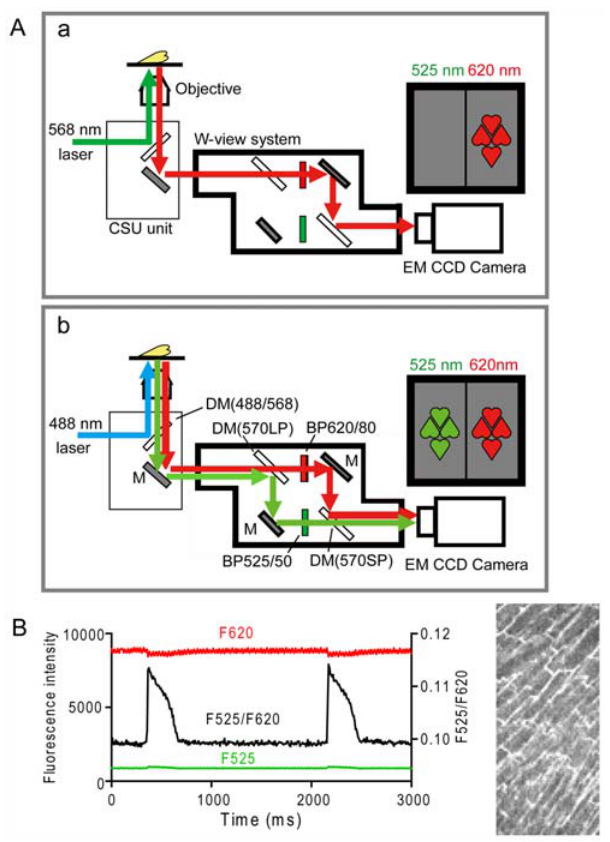
Figure 1. Schematic diagram of optical system ( A ) and typical ratiometric membrane potential signal ( B ). A CSU unit with a Nikpow spinning disk inside, W-view system, and EM-CCD camera are attached to the microscope ( A ). DM, dichroic mirror; M: mirror; BP, band-pass filter. A-a and - b show the same system with different selections of wavelengths. A-a is for determination of Ca 2 + signal with rhod-2. A-b is for membrane potential signals with di-4-AENPPS. See text for details. B . Individual di-4-ANEPPS fluorescence signals (F525 and F620) and a ratio signal (black line) obtained from whole field of view in a cardiac